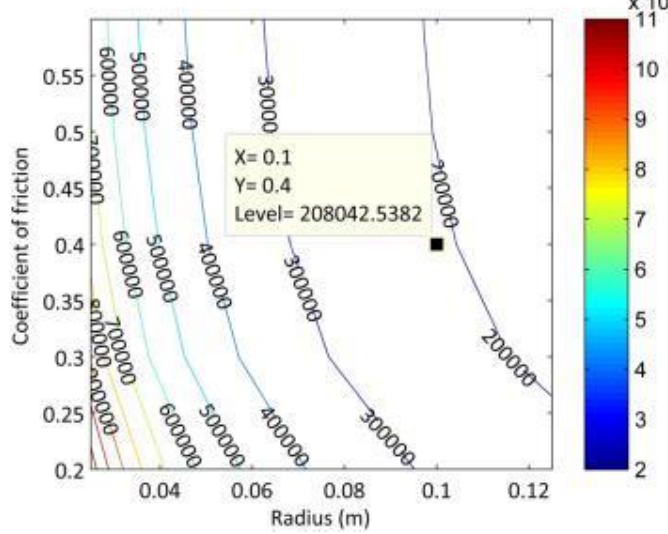
Figure 7. Reaction forces (N) at the pin (LHS).